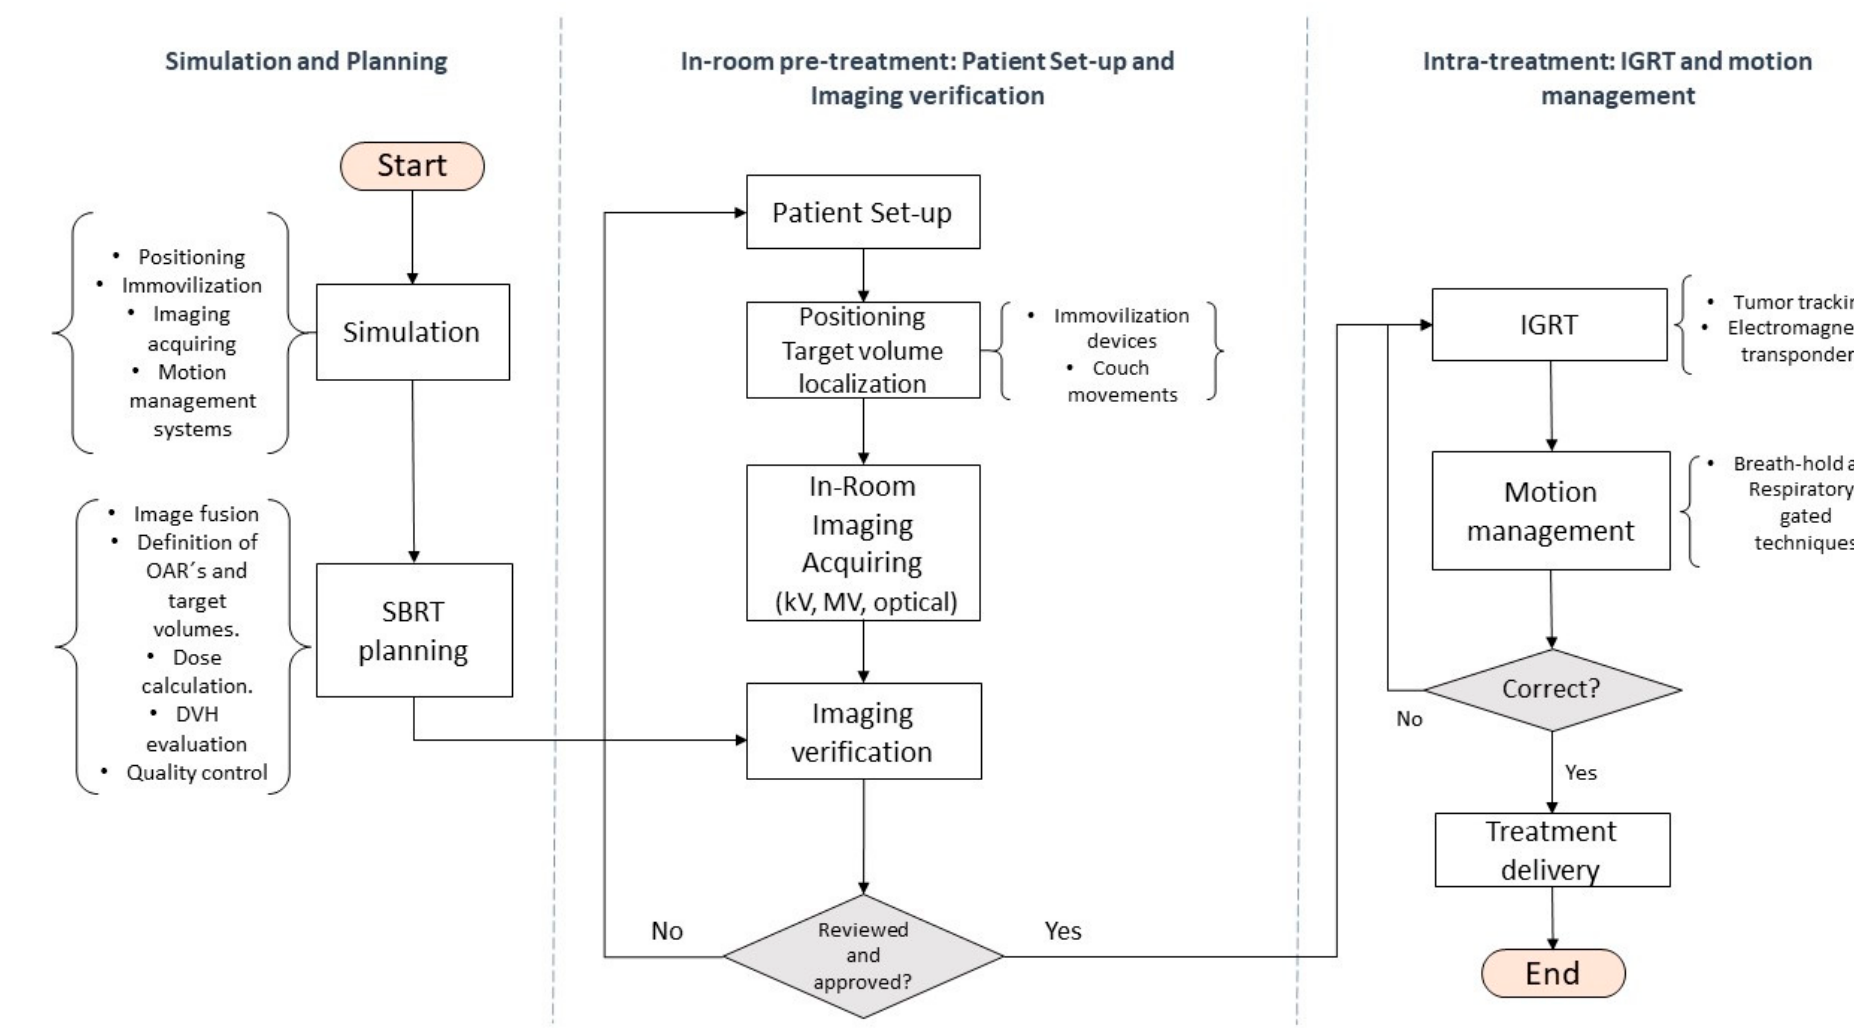
Figure 3. Flow chart describing the minimum technical requirements necessary to carry out the SBRT process. Local control and overall survival.